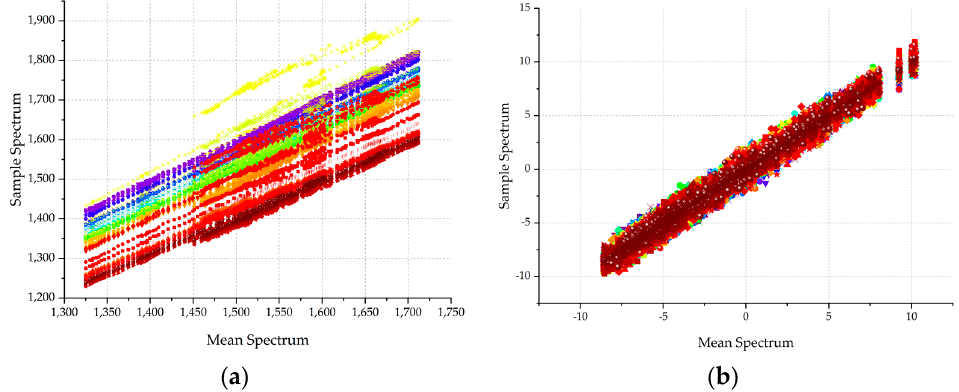
Figure 3. Raman scatter effects plots for evaluation of needed preprocessing of spectral data ( a ) shows scatter effects of raw spectral data and ( b ) shows scatter effects after preprocessing.